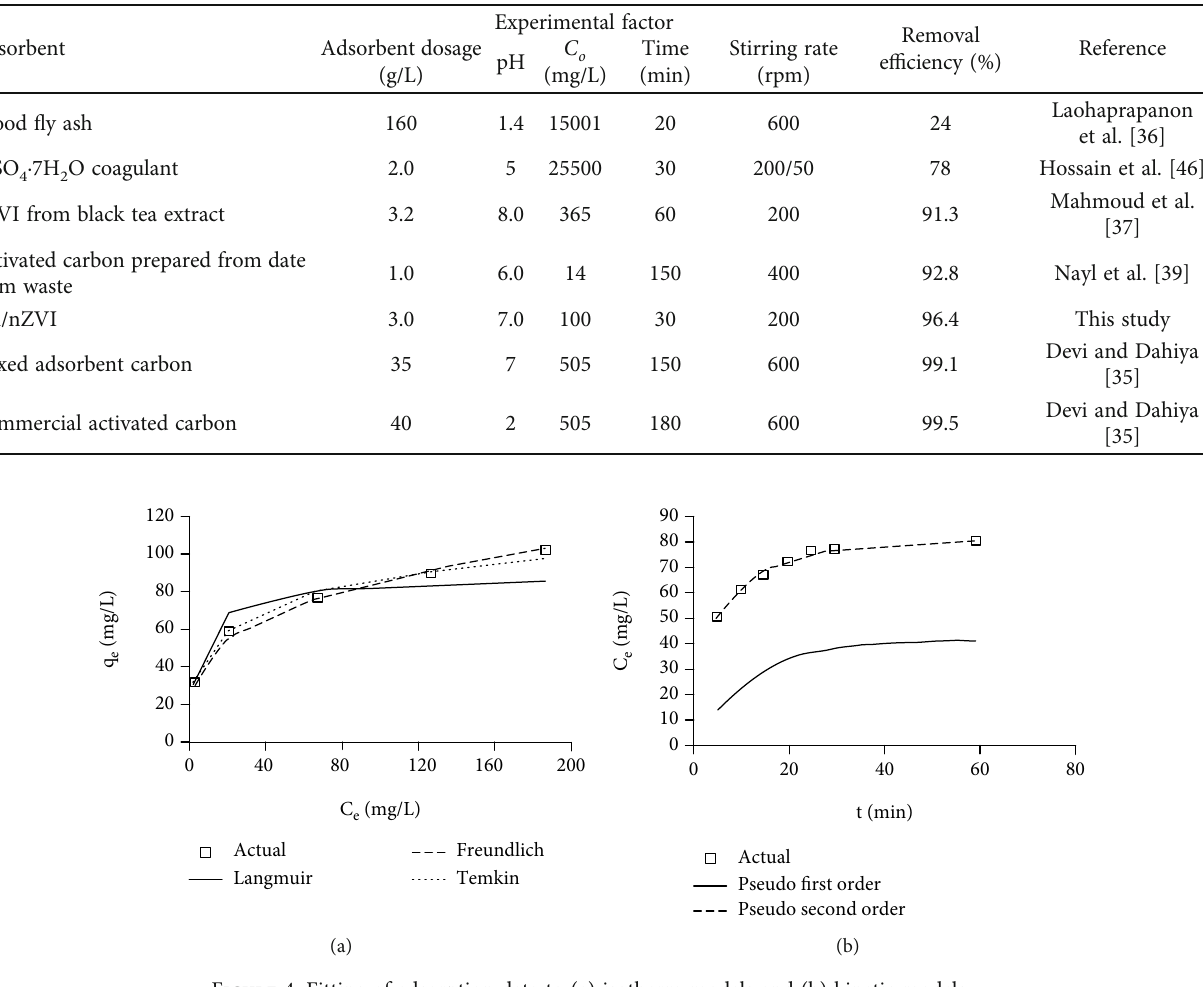
Figure 4: Fitting of adsorption data to (a) isotherm models and (b) kinetic models. Table 3: Results of isotherm and kinetic studies for BOD removal by CA/nZVI